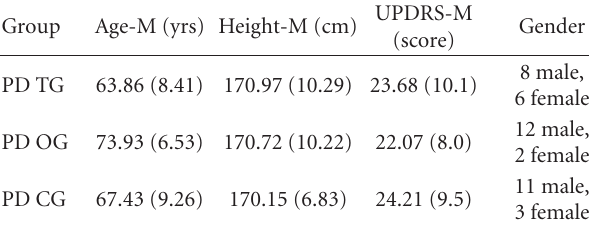
Table 1: Characteristics of the three